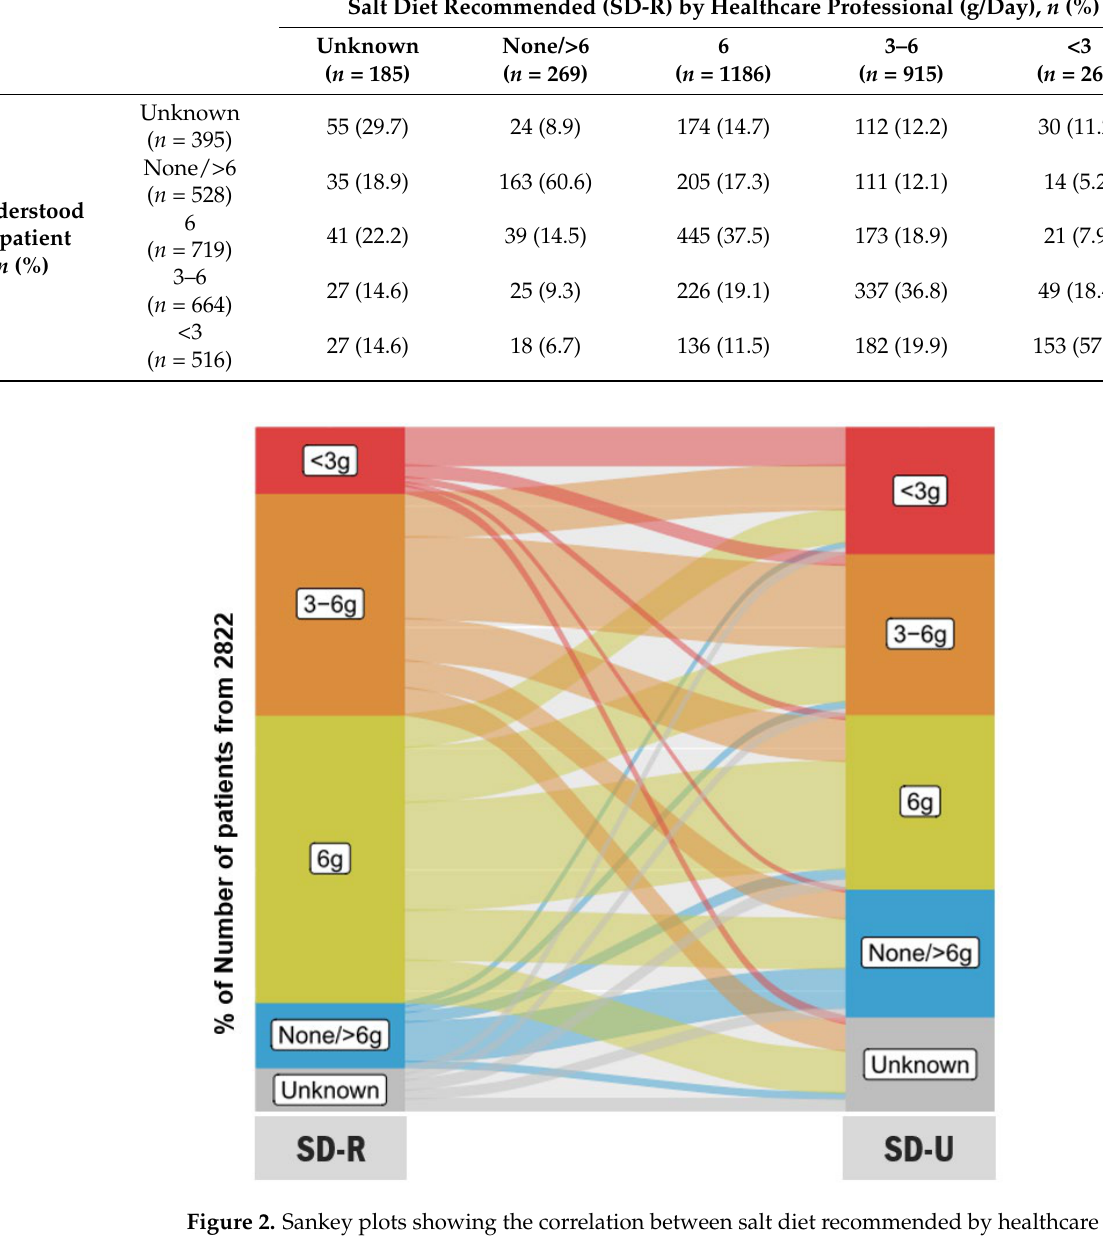
Table 3. Concordance between salt diet recommended (SD-R), by the healthcare professional, and salt diet understood (SD-U), by the patient.